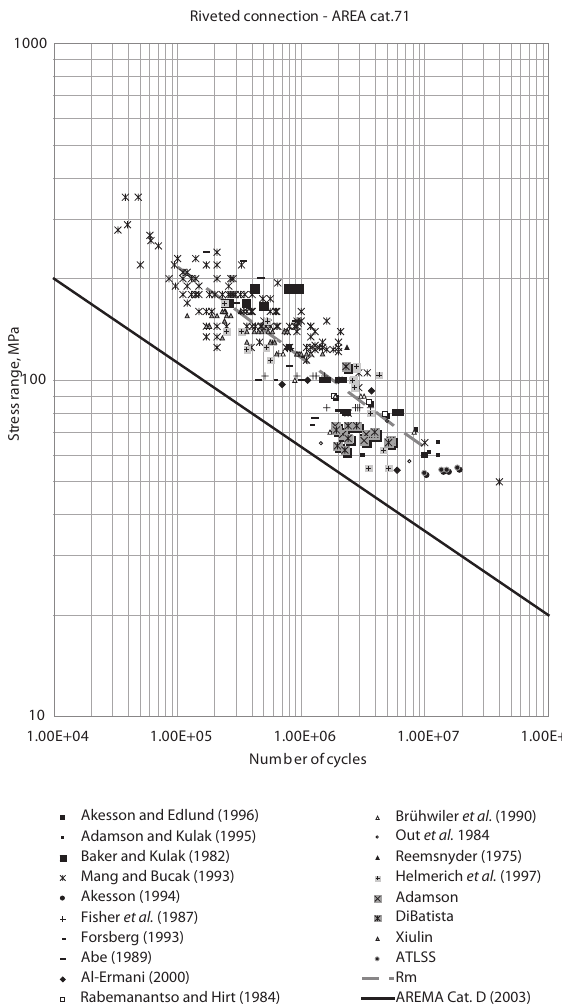
Fig. 5. Test data and fatigue design curves, bending category detail C = 90, C = 71, C = 63 according EN